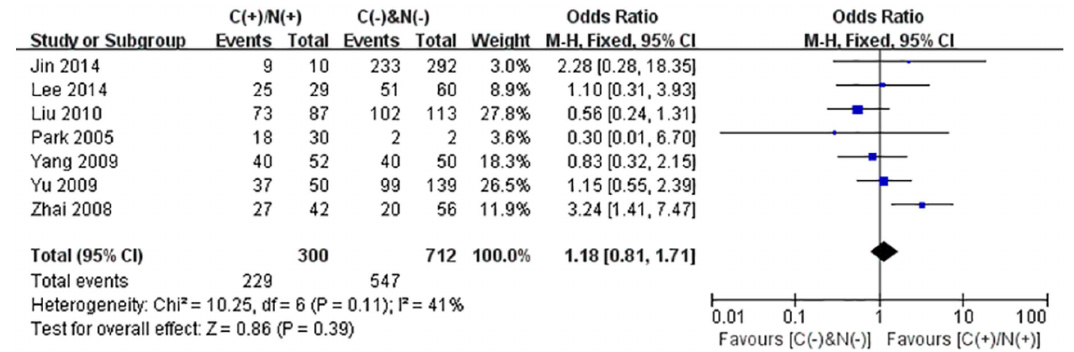
Figure 7. Forest plot of odds ratio for the association of b -catenin expression in cytoplasm and/or nucleus with TNM stage.